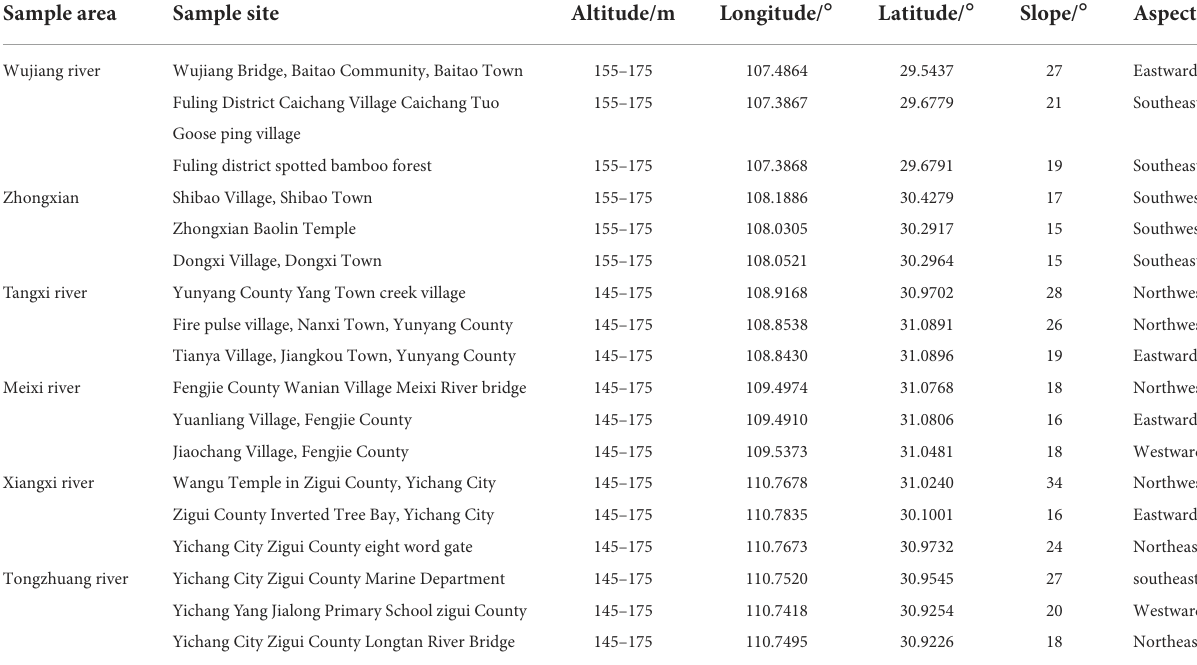
TABLE 1 Sampling point details.